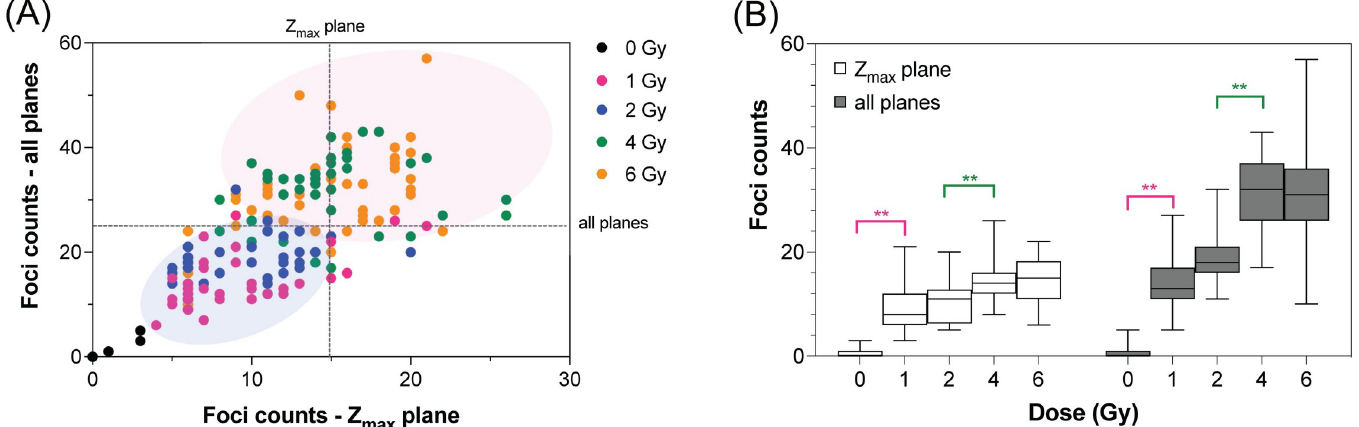
Fig 6. Dose response of lymphocytes using foci counting of microscopy images. (A) Dot plot of number of foci counts from all planes (y-axis) and Z max plane (x-axis) (n = 5, 30–50 lymphocytes per dose). Blue and pink shadows highlight the two distinct regions where data are aggregated. (B) Box plot of foci counts as a function of dose. All p -values < 0.01; 0 Gy vs 1, 2, 4, 6 Gy; 1 Gy vs 4, 6 Gy; 2 Gy vs 4, 6 Gy for both all planes and Z max plane. Asterisks ( �� ) refer to p < 0.01 for comparison between adjacent doses (0 vs 1 Gy and 2 vs 4 Gy).